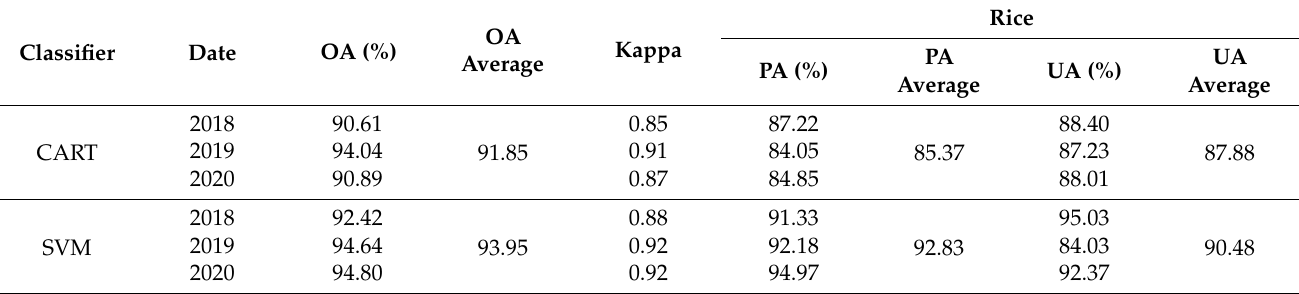
Table 6. The accuracy of rice mapping results under the SOI strategy. CART means classification and regression trees method; SVM means support vector machine method. OA means overall accuracy; UA means user’s accuracy and PA means producer’s accuracy.